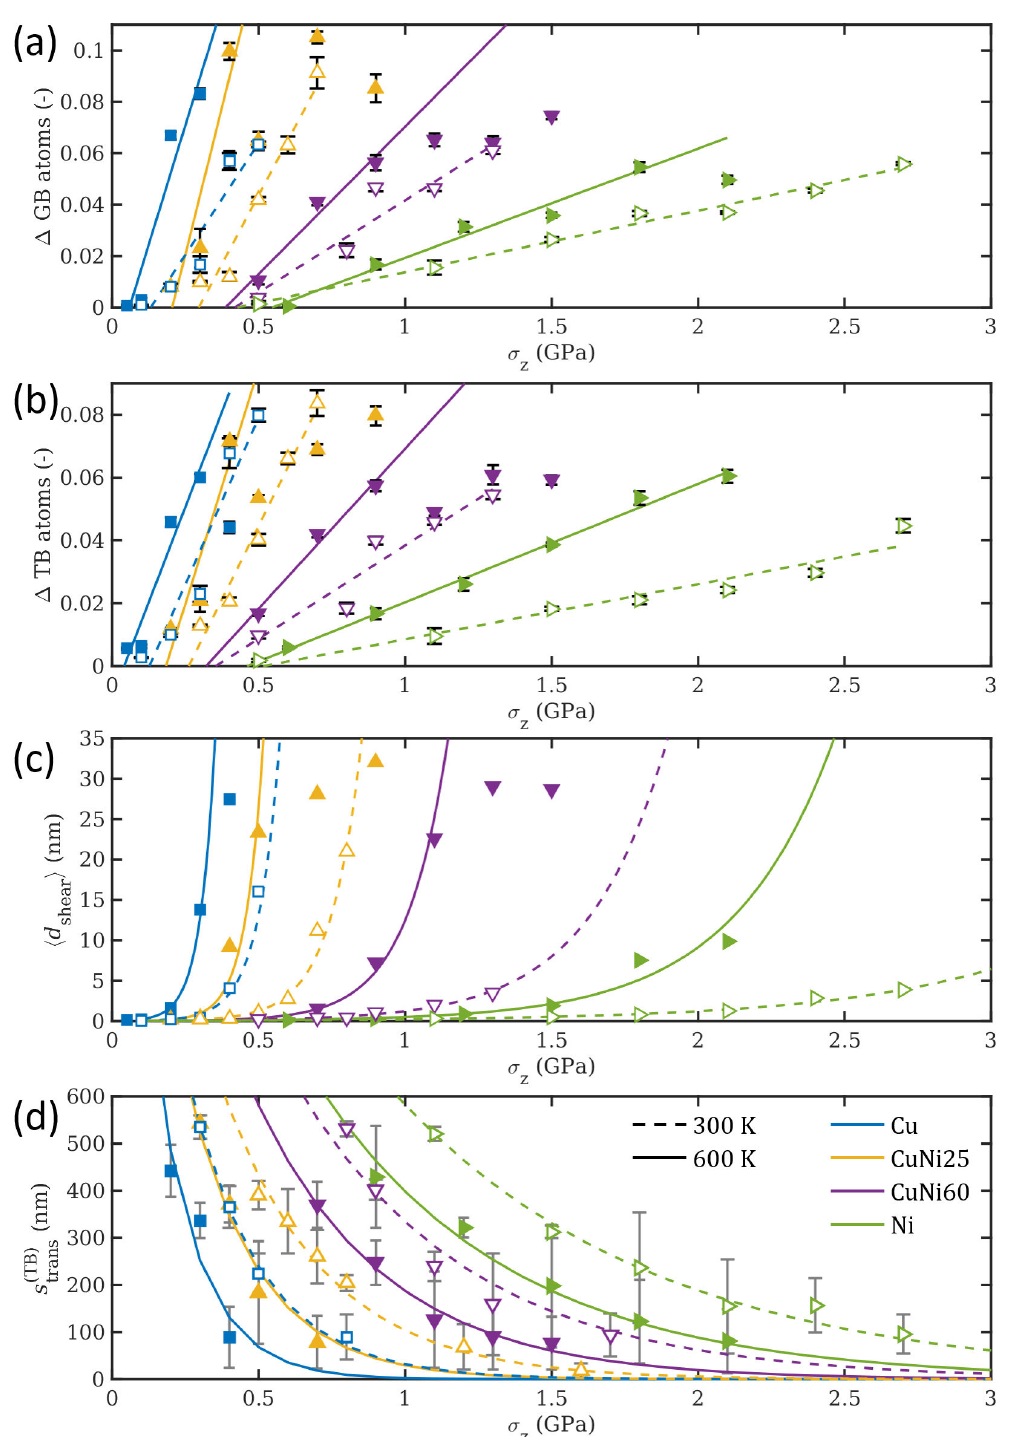
Figure 4. The increase in grain boundary and defect atoms ∆ GB ( a ), the increase in twin boundary and stacking fault atoms ∆ TB ( b ), the mean shear layer thickness (cid:104) d (cid:105) ( c ), and the twinning transition sliding length s ( TB ) ( d ) over the normal shear trans pressure σ z at 300 K (dashed curves, hollow symbols) and 600 K (solid curves, filled symbols) with linear or exponential fits to the data. Different symbol shapes and colors denote different compositions. At 600 K, there is a normal pressure after which ∆ GB, ∆ TB, and (cid:104) d shear (cid:105) saturate. Those data points were excluded from the respective fits to better capture the underlying